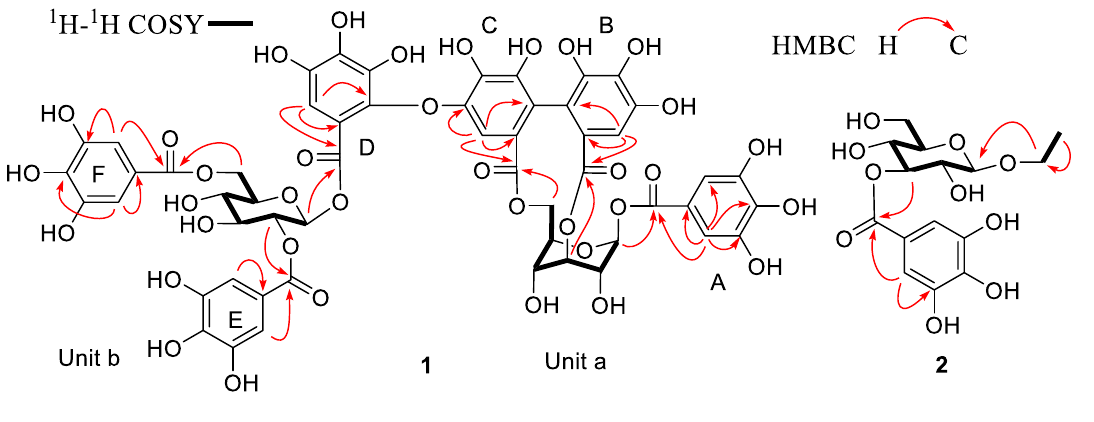
Fig. 2 Key 1 - 1 H COSY and HMBC correlations of 1 –